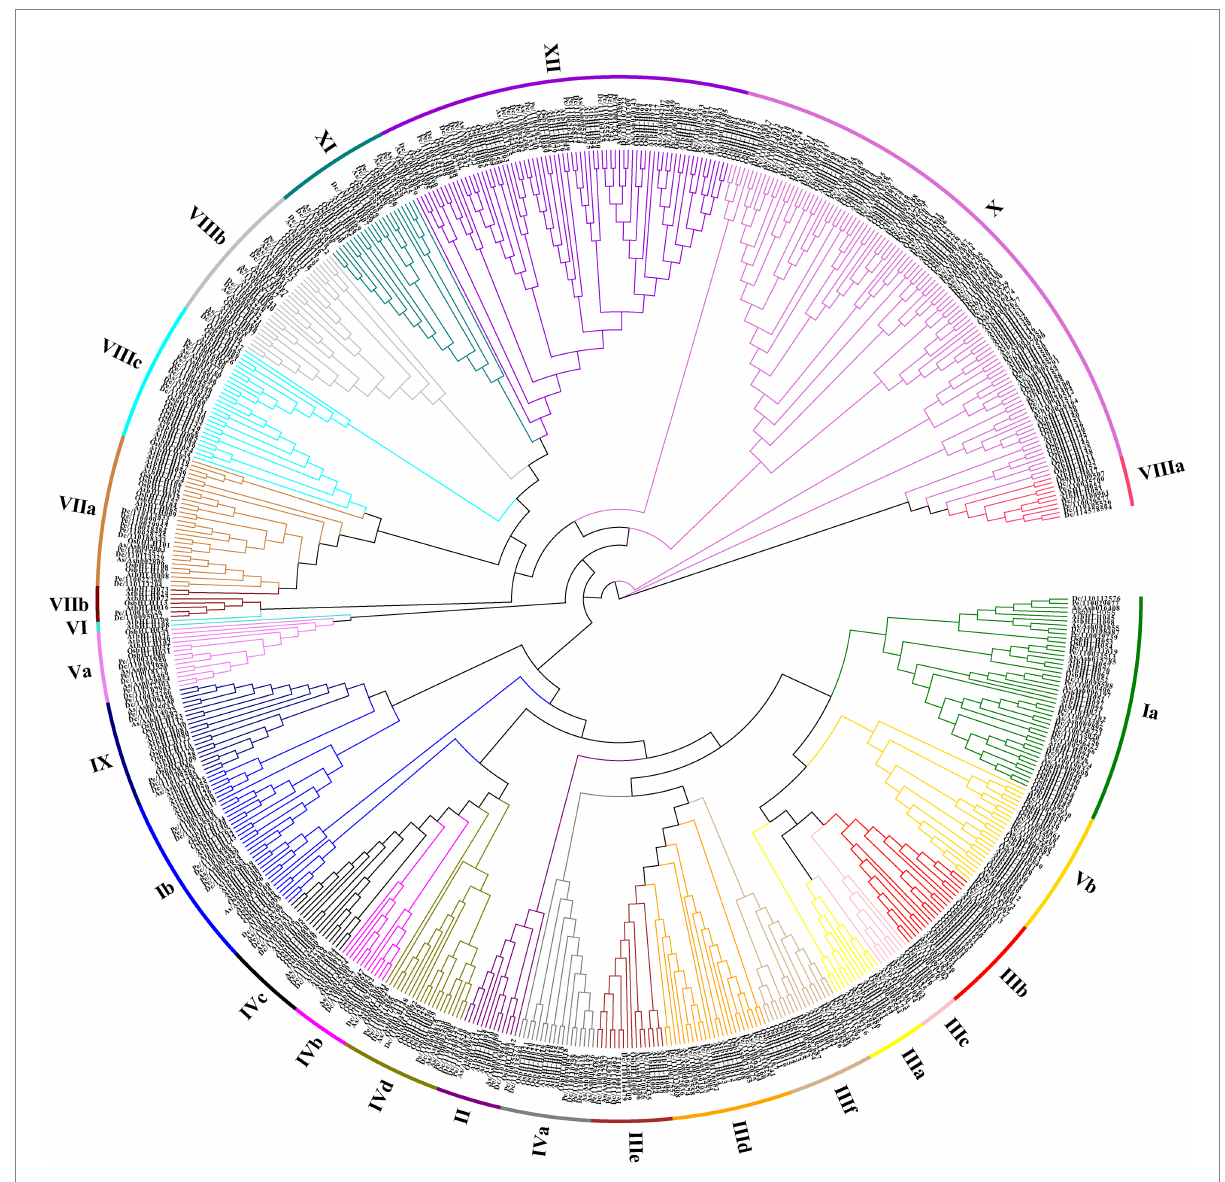
FIGURE 1 Phylogenetic analysis of the basic helix–loop–helices (bHLHs) from Dendrobium catenatum , Phalaenopsis equestris , Apostasia shenzhenica , Arabidopsis , and Oryza sativa genome. The neighbor-joining (NJ) tree was drawn using MEGA 7.0 with 1,000 bootstrap replicates.